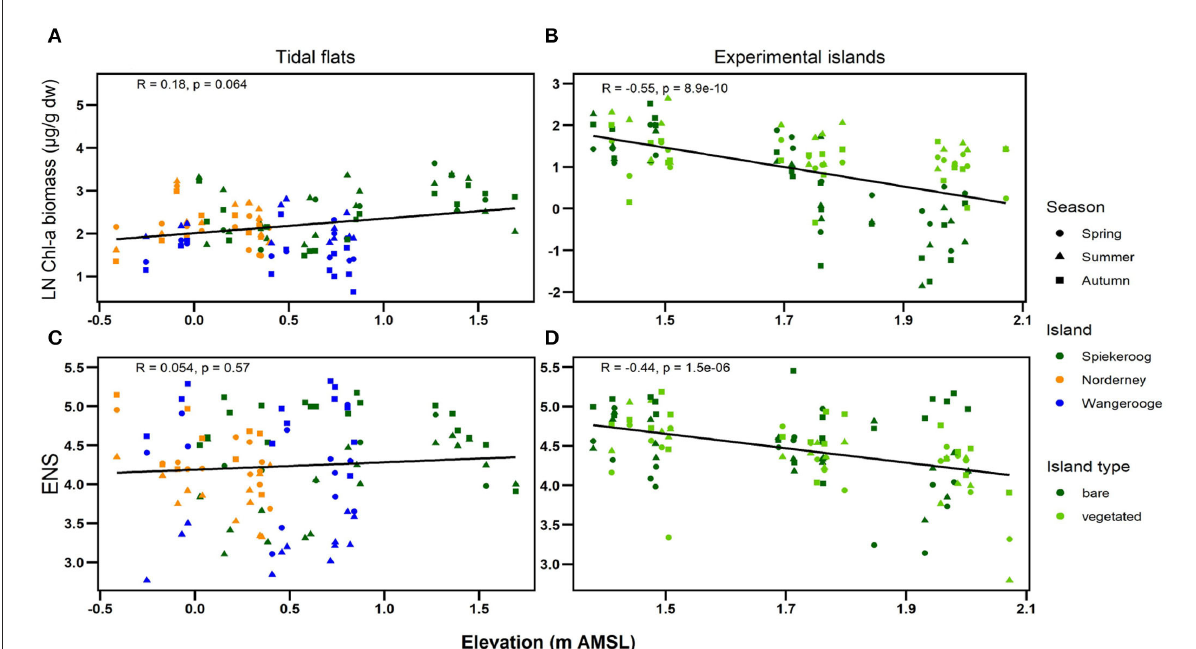
FIGURE3 Relationship between logarithmic-transformed Chl-a biomass in micrograms per gram dry weight sediment ( µ g/g dw) and pigment diversity (ENS) against elevation (meters above mean sea level; m AMSL) on natural tidal flats [left panel; (A,C) ] and on experimental islands (bare and vegetated) [right panel; (B,D) ].